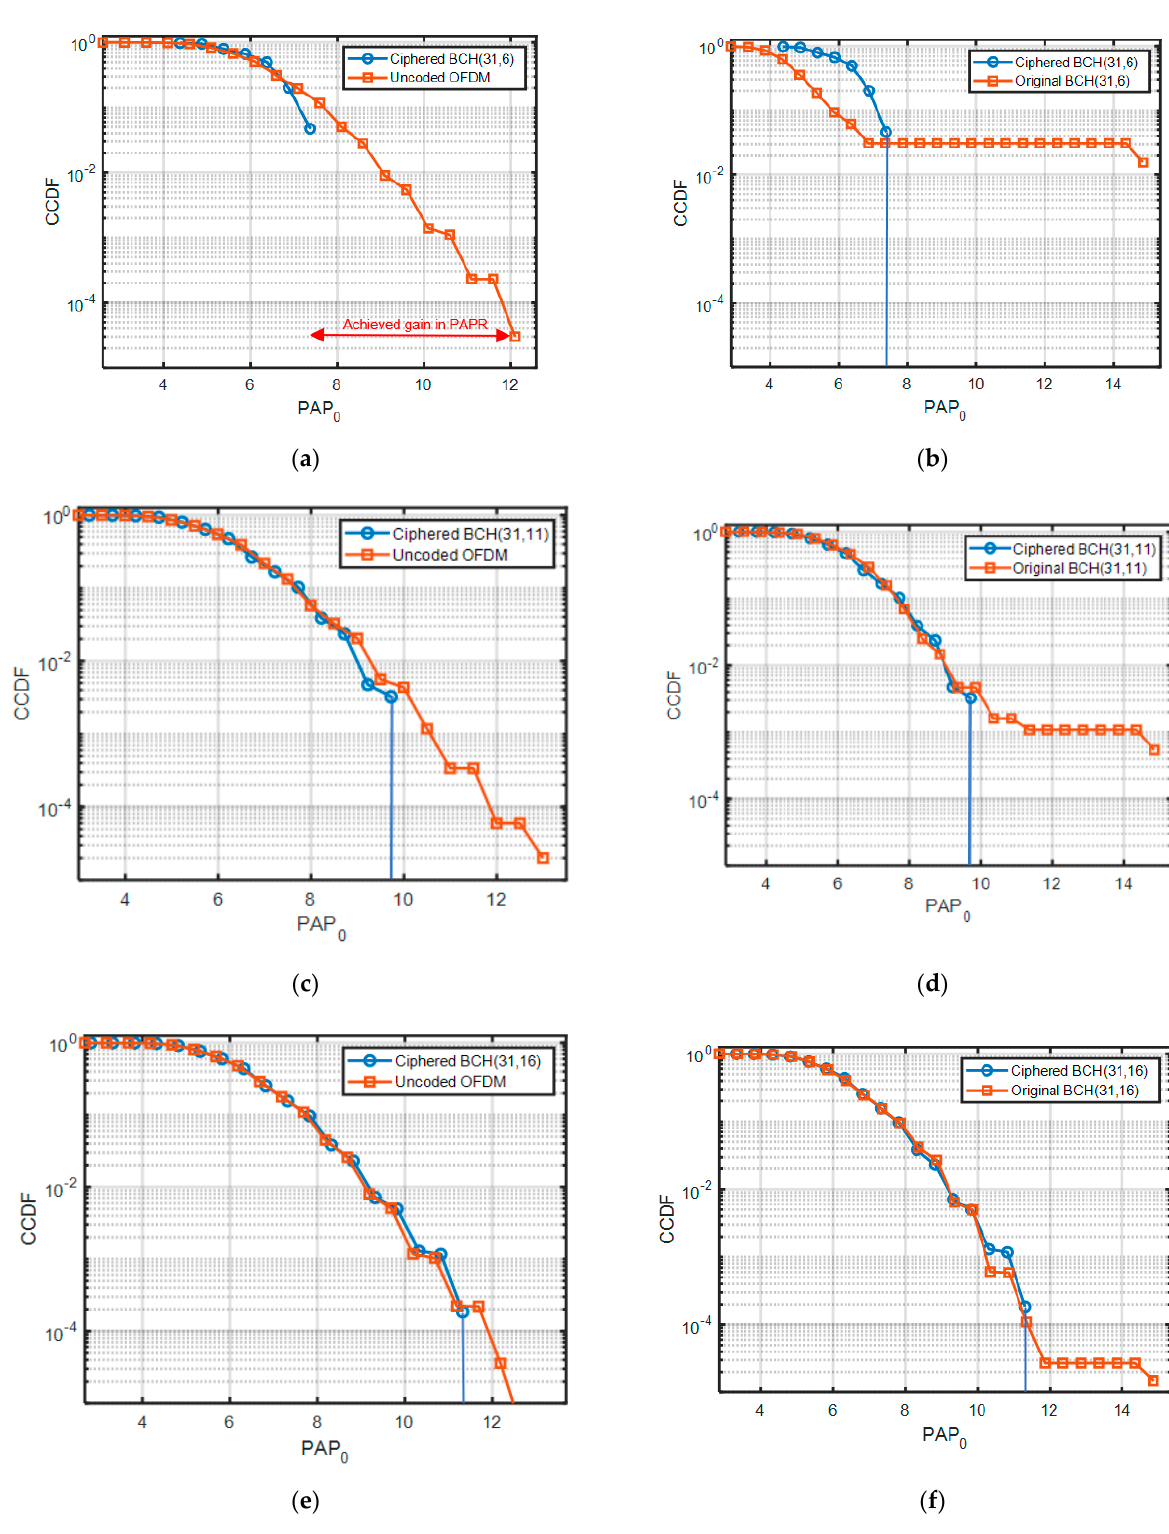
Figure 8. PAPR performance of the proposed technique for ciphered BCH(31, k ) systems. ( a ) Ciphered BCH(31,6) vs uncoded OFDM, ( b ) Ciphered BCH(31,6) vs original BCH(31,6), ( c ) Ciphered BCH(31,11) vs uncoded OFDM, ( d ) Ciphered BCH(31,11) vs original BCH(31,11), ( e ) Ciphered BCH(31,16) vs uncoded OFDM and ( f ) Ciphered BCH(31,16) vs original BCH(31,16).